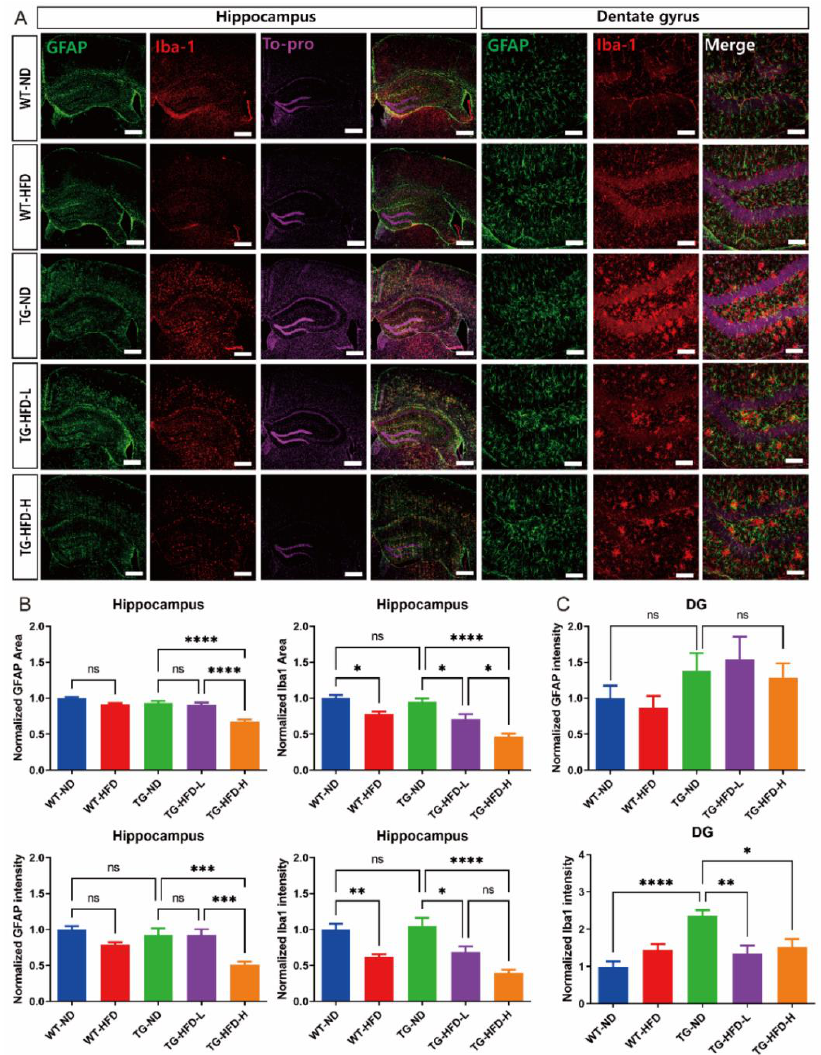
Figure 4. Analysis of astrocyte and microglia reactivity in the hippocampal dentate gyrus (DG) under a high-fat diet (HFD). Representative immunofluorescence images of glial fibrillary acidic protein (GFAP) and ionized calcium binding adaptor molecule 1 (Iba1) staining in the hippocampus of female mice. Scale bars = 100 µ m ( A ). Analysis of the stained GFAP area and its intensity in the entire hippocampus ( B , left panel). Analysis of the stained Iba1 area and its intensity in the entire hippocampus ( B , right panel). Analysis of the stained GFAP ( C , top panel) and Iba1 ( C ), bottom panel) intensities in the hippocampal DG. ns (not significant), * p < 0.05, ** p < 0.01, *** p < 0.001, **** p < 0.0001 (one-way analysis of variance with Tukey post hoc analysis). Data are presented as the mean ± standard error of the mean. The number of mice in each group ranged 9–10. ND, normal chow; WT, wildtype; TG